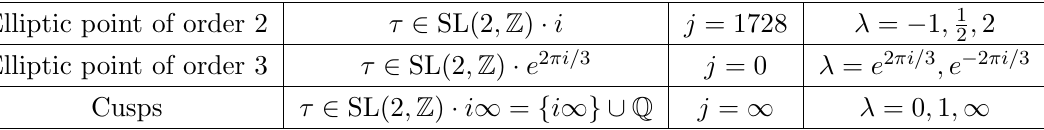
Table 1 . Cusps and elliptic